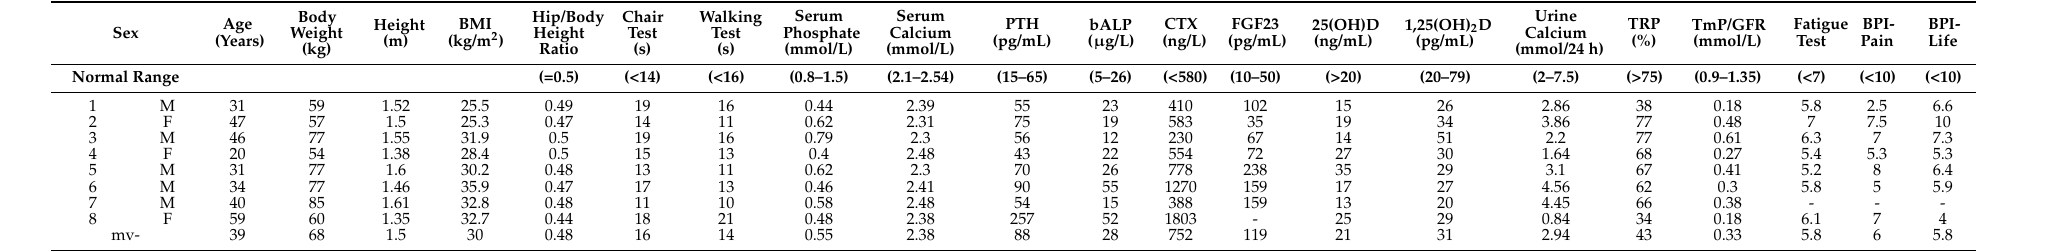
Table 1. Baseline characteristics of patients with XHR after suspension of calcitriol and phosphate salts for 7 days. The reference range of the variables is in brackets. PTH: intact parathyroid hormone; bALP: bone alkaline phosphatase; CTX: C-terminal telopeptide of type I collagen; FGF23: fibroblast growth factor 23;